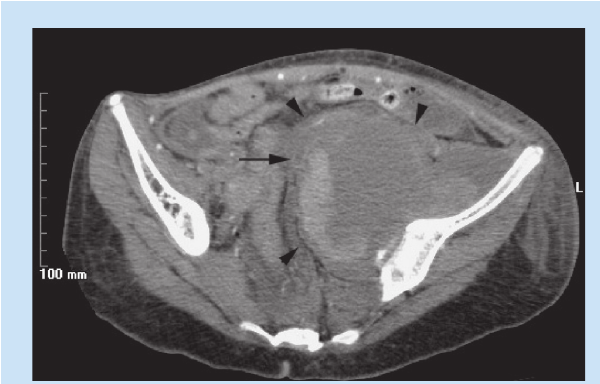
Fig. 4. CT angiogram. A large pelvic haematoma is present (arrowheads) due to contained rupture of the left common iliac artery aneurysm. The right common iliac artery is occluded. Active arterial haemorrhage is visible (arrow).